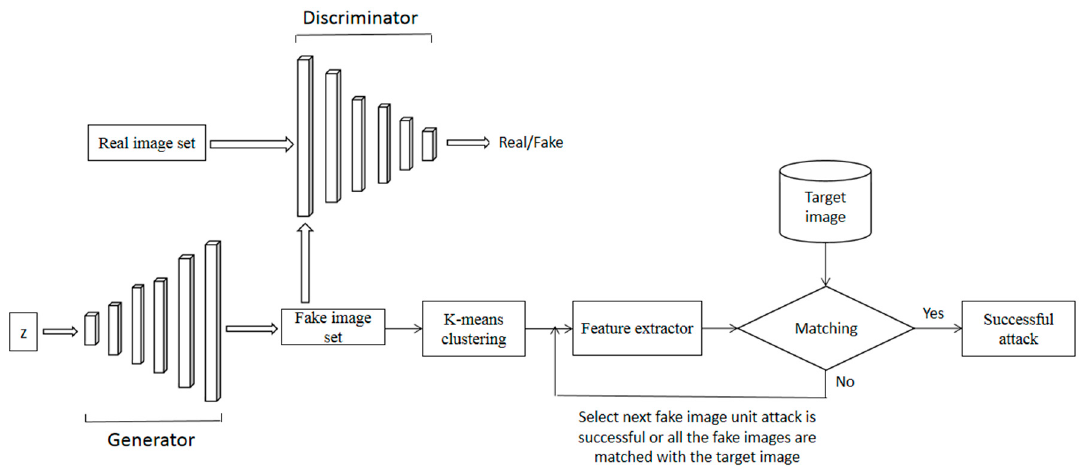
Figure 7. Framework of palmprint false acceptance attack with deepconvolutional GAN (DCGAN).